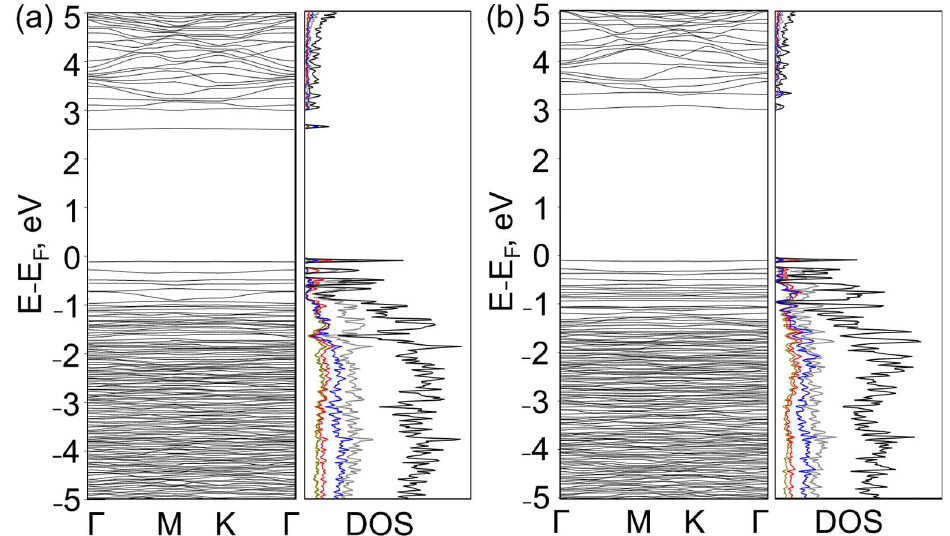
Figure 3. Band structures and densities of states of hydrogenated diamane-like G/BN structures with θ = 25.3° with C-B ( a ) and C-N ( b ) bonds in the AA-stacked area. Cyan, red, blue, gray and black lines correspond to H, B, C, N and total DOS, respectively.